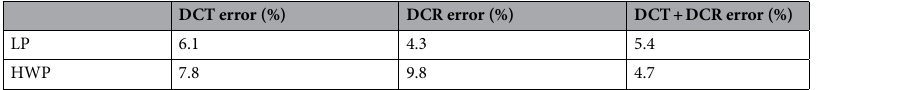
Table 1. Maximum polarimetric error percentage of the LP and HWP from the corresponding expected